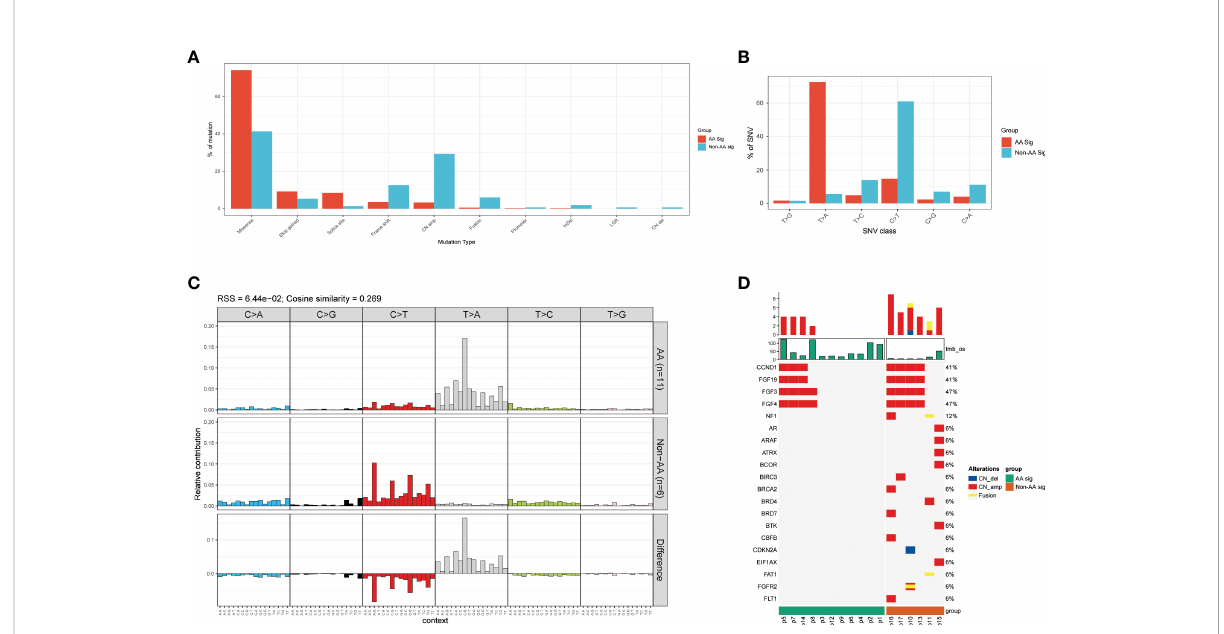
FIGURE 2 Mutational pattern in AA Sig and non-AA Sig cohorts (A) The detection rates of different mutation types in both cohorts. (B) percentage of SNV mutations in each of six possible mutation classes in both cohorts. (C) Trinucleotide contexts for SNVs in each of six possible mutation classes in both cohorts. (D) Copy number variations of the two cohorts. SNV, single nucleotide